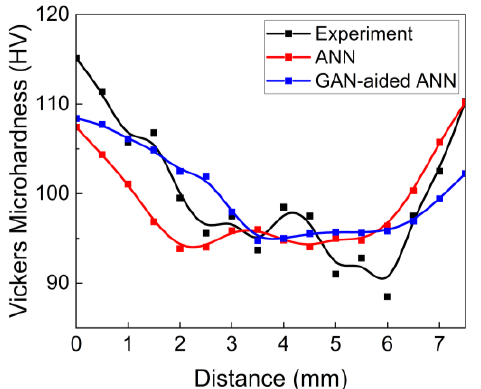
Figure 5. Line profile of Vickers microhardness values along the distance across the cross-section subjected to the eight-pass MPCR deformation. The data predicted by ANN and GAN-aided ANN approaches were also presented in the same format.